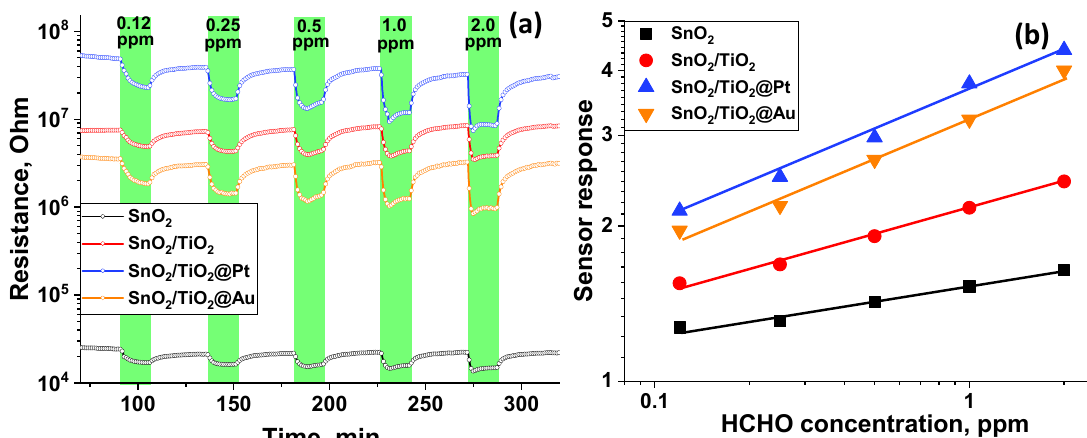
Figure 8. Change in the nanocomposites’ resistance depending on HCHO concentration of HCHO ( a ) and calibration curves ( b ) at T = 200 °C.